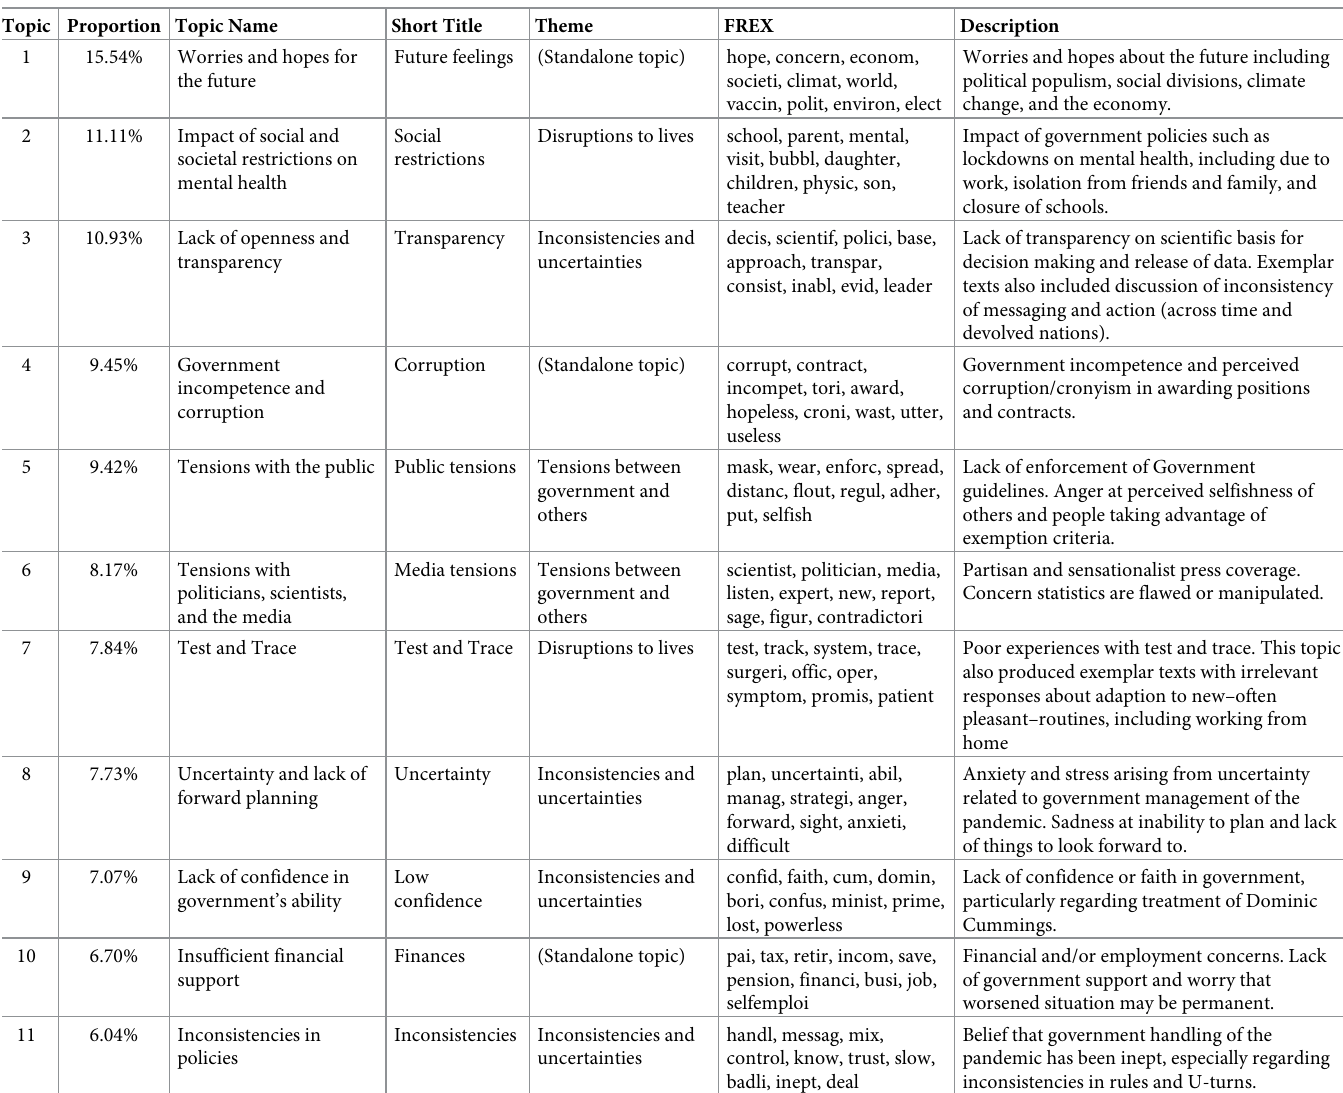
Table 3. Topics extracted from structural topic